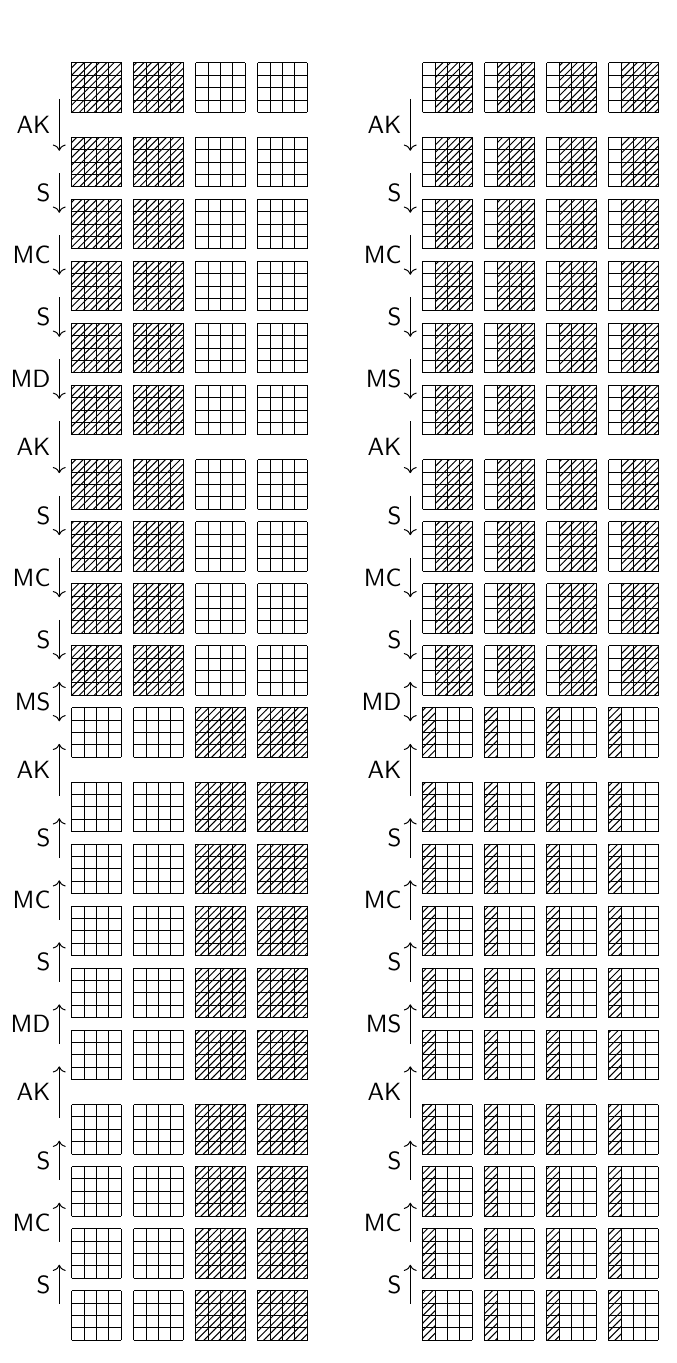
Figure 21: Paths A (left) and B